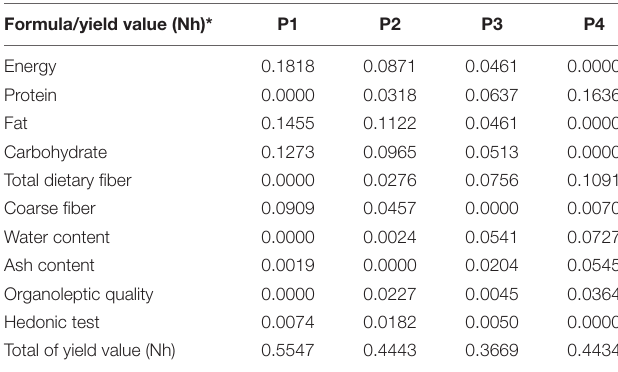
TABLE 5 | The results of the determination of the best